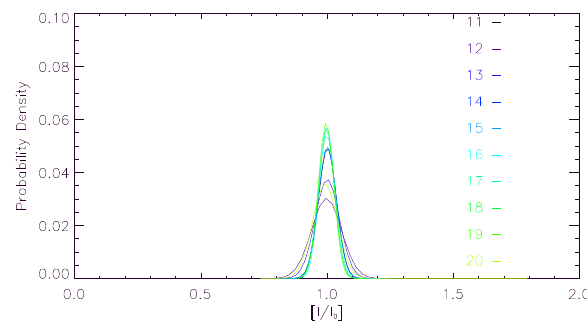
Figure 8 The normalized intensity distribution for a period of 10 seconds starting at 07:22:10 UTC (10 times 1 second). Fig. 8. The normalized intensity distribution for a period of 10s starting at 07:22:10UTC (10 times 1s).